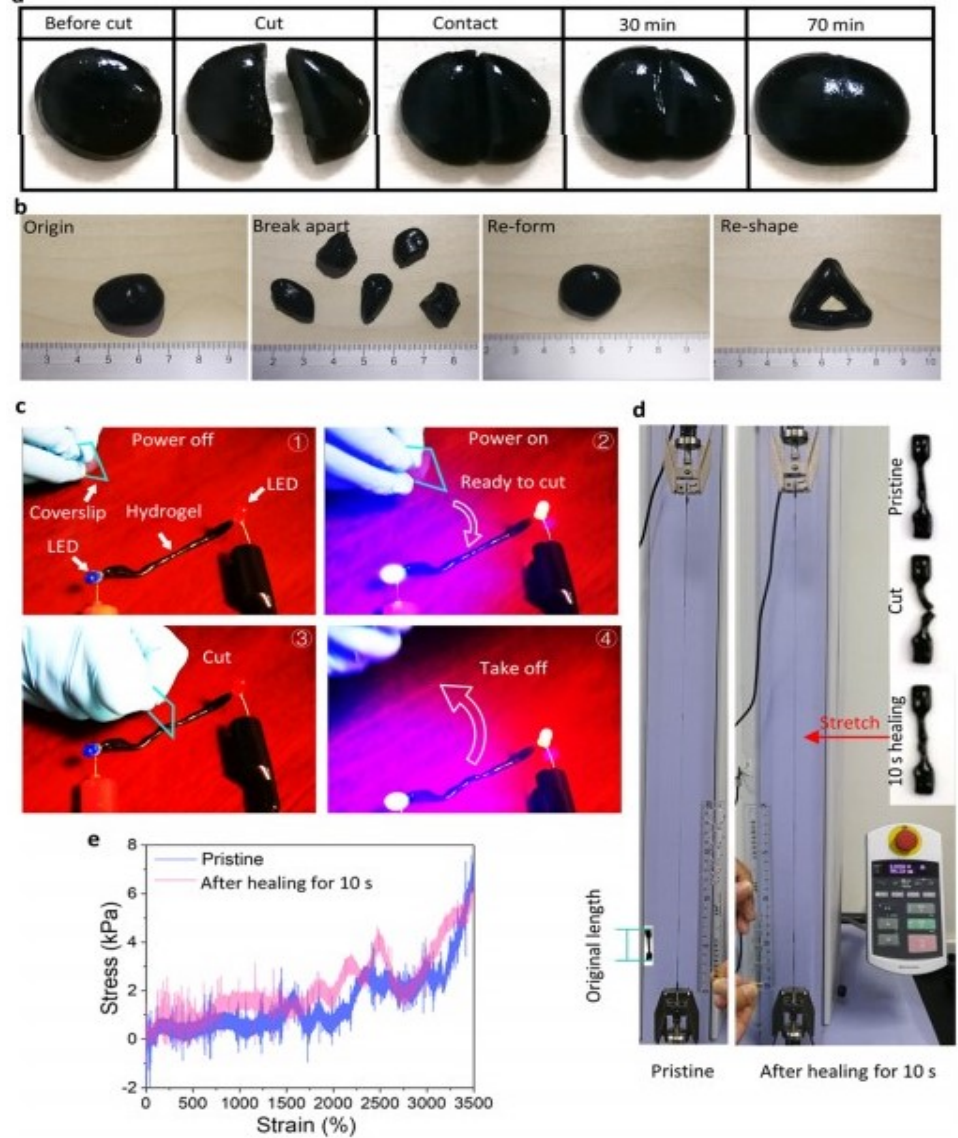
Figure 6. Methods to confirm self-healing ability of hydrogel ( a ) Cut heal ability within 70 min without stimuli ( b ) Shape changeable capability ( c ) Circuit obtained with the hydrogel that can selfheal ( d ) Stretchability performed with tensile testing apparatus with pristine and self-healed hydrogel ( e ) Stress-strain curves obtained from previous stretchability experiment. (Reproduced with permission from Ref. [99]. Copyright 2020, American Chemical